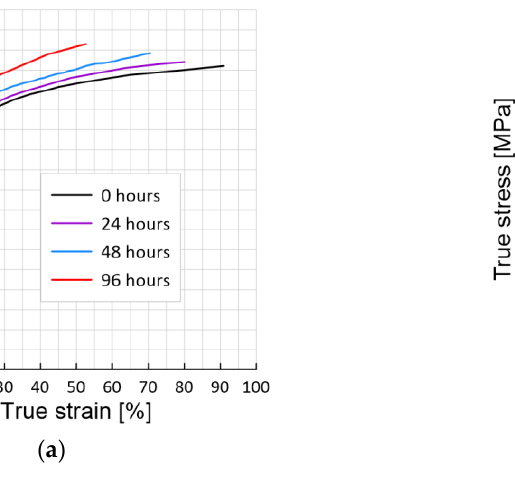
Figure 5. Stress-strain curves for hydrogen-charged and hydrogen-free samples with 0% ( a ) and 75% ( b ) pre-strain at ambient temperature.